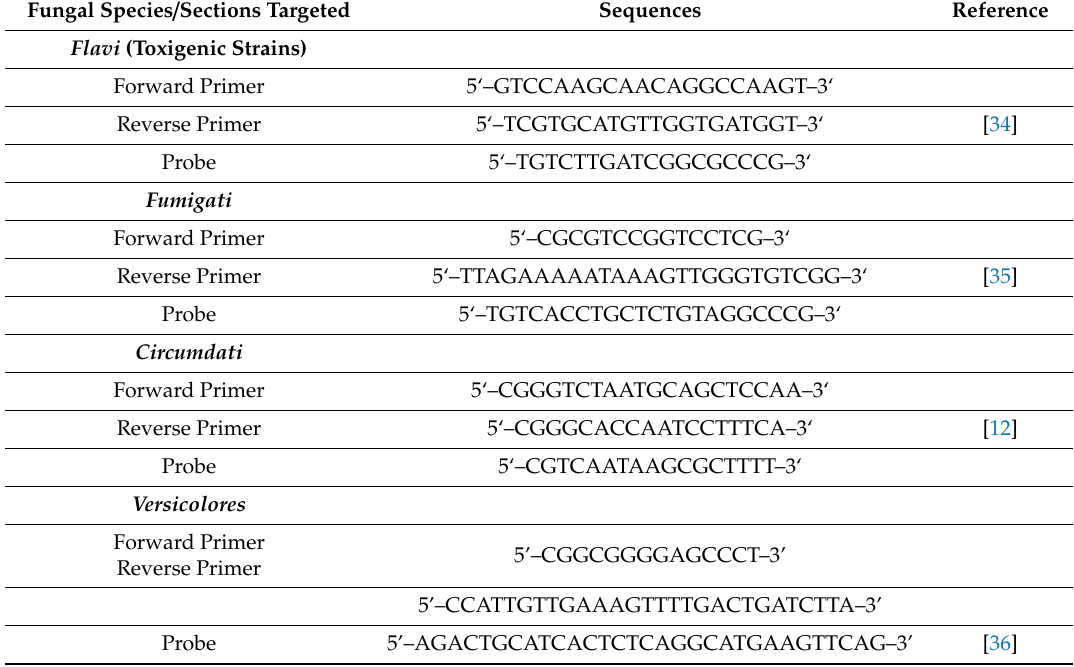
Table 2. Sequence of primers and TaqMan probes used for real-time